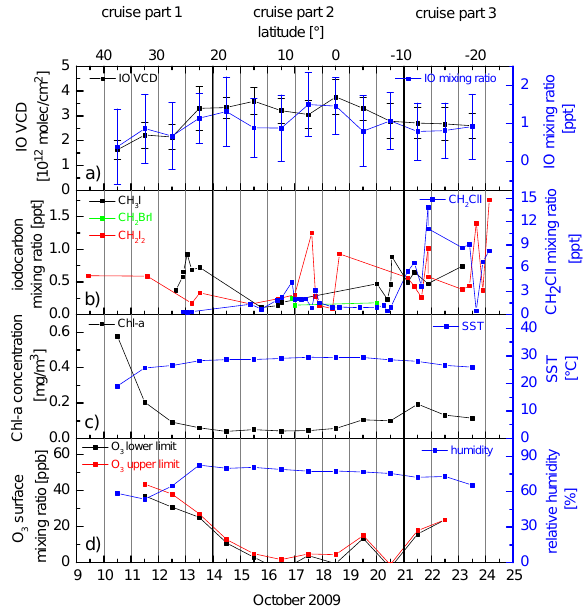
Fig. 7. Latitudinal cross-section of daily averaged IO VCDs and Fig. 7: Latitudinal cross-section of daily averaged IO VCDs and mixing ratios with the mixing ratios with the error bars indicating the respective daily av- error bars indicating the respective daily averaged total error (panel a), iodocarbon mixing eraged total error (a) , iodocarbon mixing ratios (b) , daily averaged ratios (panel b), daily averaged Chl-a concentration and sea surface temperature (SST) Chl a concentration and sea surface temperature (SST) (c) as well (panel c) as well as the O 3 mixing ratios averaged for the lowest 100 m from each of the as the O 3 mixing ratios averaged for the lowest 100m from each of different O 3 -sonde profiles (upper limit of the uncertainty range in red and lower limit of the different O 3 -sonde profiles (upper limit of the uncertainty range the uncertainty range in black), and the daily averaged relative humidity (panel d). in red and lower limit of the uncertainty range in black), and the daily averaged relative humidity (d)